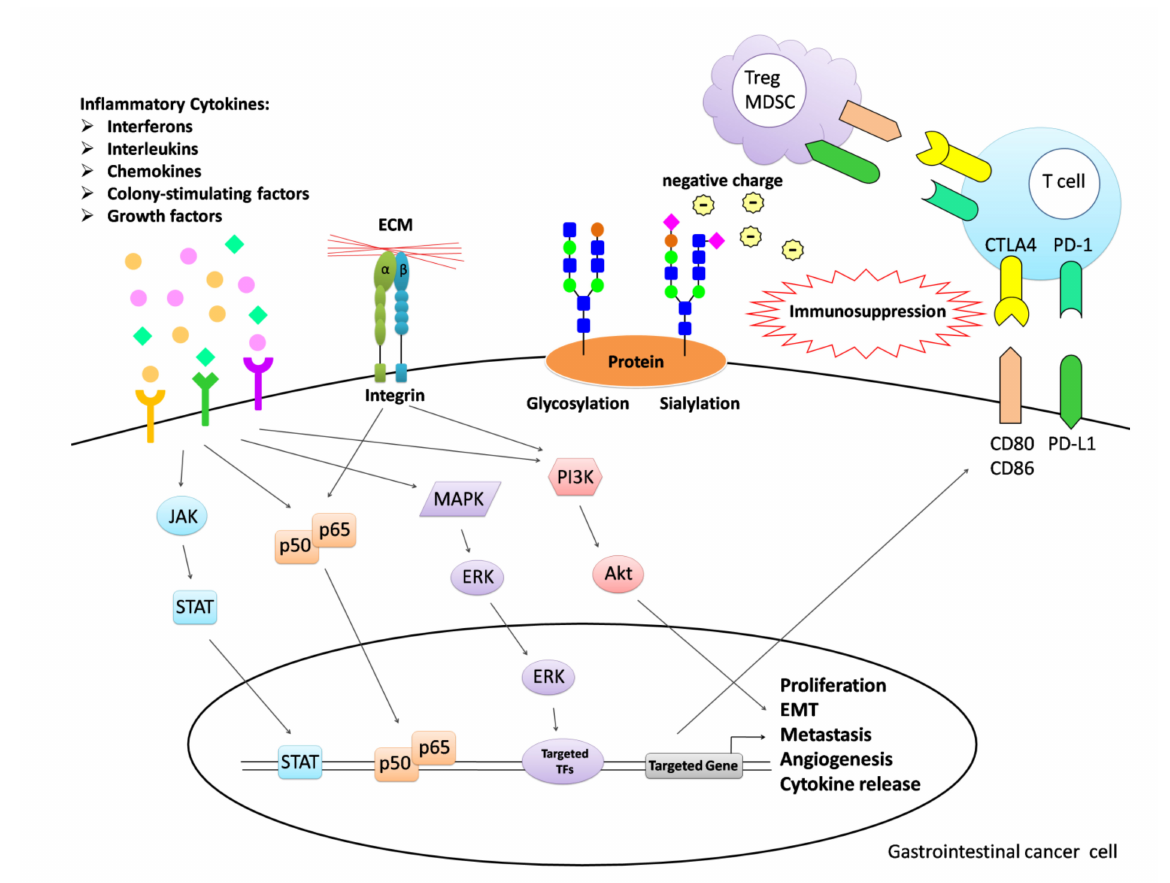
Figure 1. Overview of cell–cell communication in the tumor microenvironment. Inflammatory cytokines facilitate tumor proliferation, angiogenesis, metastasis, and immunosuppression through NF- κ B, JAK/STAT, PI3K/Akt, and MAPK/ERK pathways. Integrins acting as cell adhesion molecules additionally contribute to the tumor phenotype. Infiltrating immune and tumor cells present CD80/CD86 and PD-L1, leading to loss of T cell activity. Glycosylation and sialylation on the cell surface promote metastasis and immune escape. Notably, the negative charges imparted by sialic acids enhance this